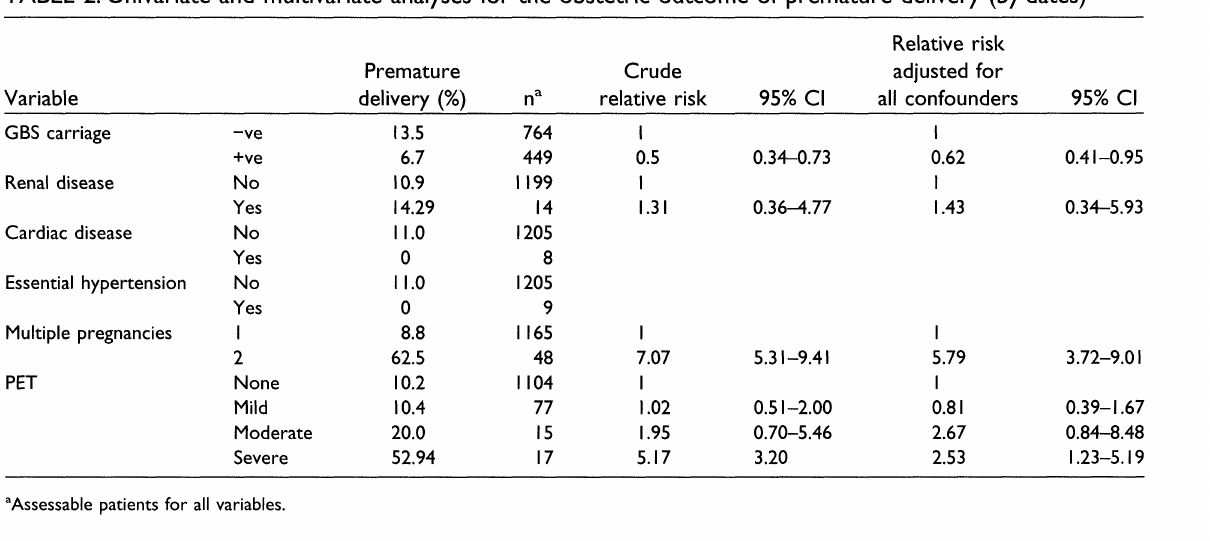
TABLE 3. Univariate and multivariate analyses for the obstetric outcome of premature delivery (by ultrasound) and preterm premature rupture of membranes Premature Crude Relative